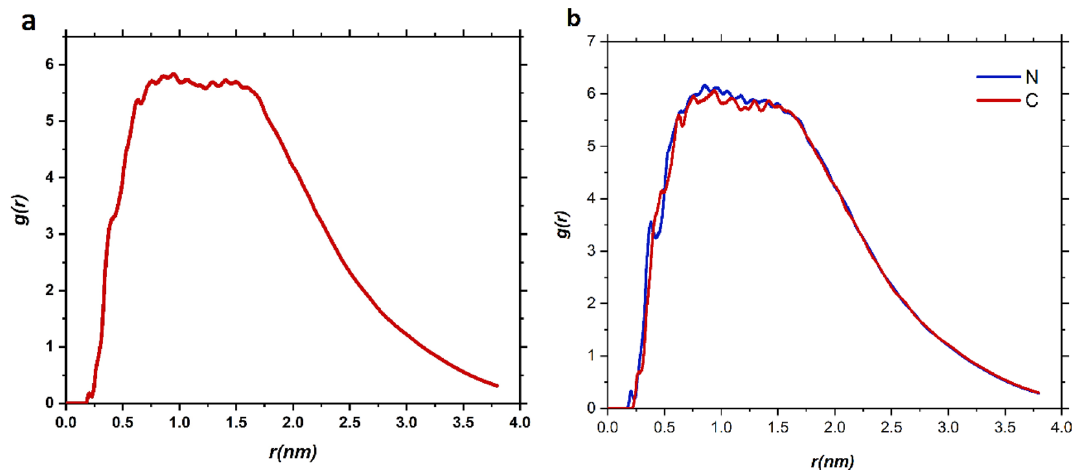
Figure 5. ( a ) Radial distribution function (RDF) of the centre of mass of the adsorbed drug molecule with respect to the carrier atoms. ( b ) atomic RDF profiles of N and C atoms with the adsorbed DOX